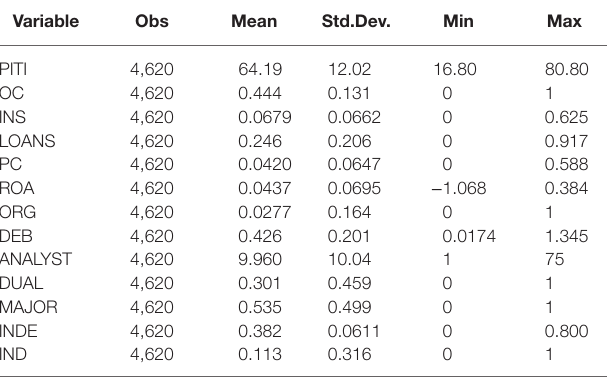
TABLE 4 | Descriptive statistics of